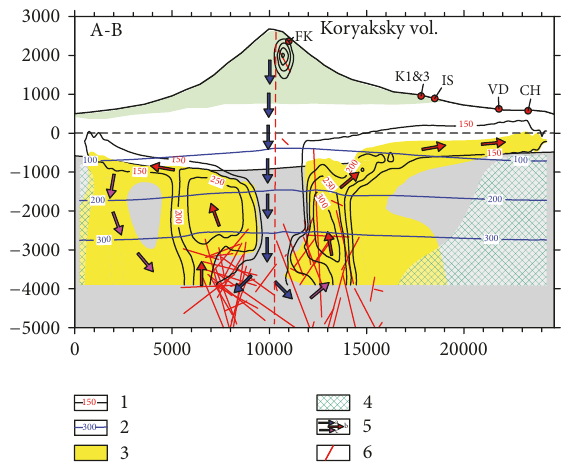
Figure 18: Conceptual TOUGH2-based model of hydrothermal circulation beneath Koryaksky Volcano. 1: temperatures, ∘ C; 2; pressures, bar; 3; regions with CO 2 partial pressures above 1 bar (i.e., CO 2 mass fractions more than 0.02); 4: regions with chloride concentrations of more than 5ppm; 5: fluid flows: a, cold, b, hot, and c, intermediate; 6: dike injection regions. For additional explanation of this figure, see legend in Figure